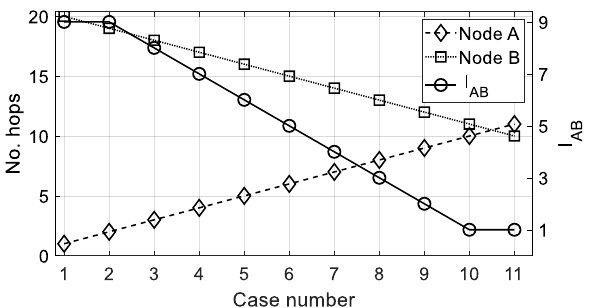
Figure 6. Importance value I AB (circles) when nodes A and B are compared under the number of hops criterion. Data: d max = 10 km, d min = 0.5 km, 𝛿 = 1.